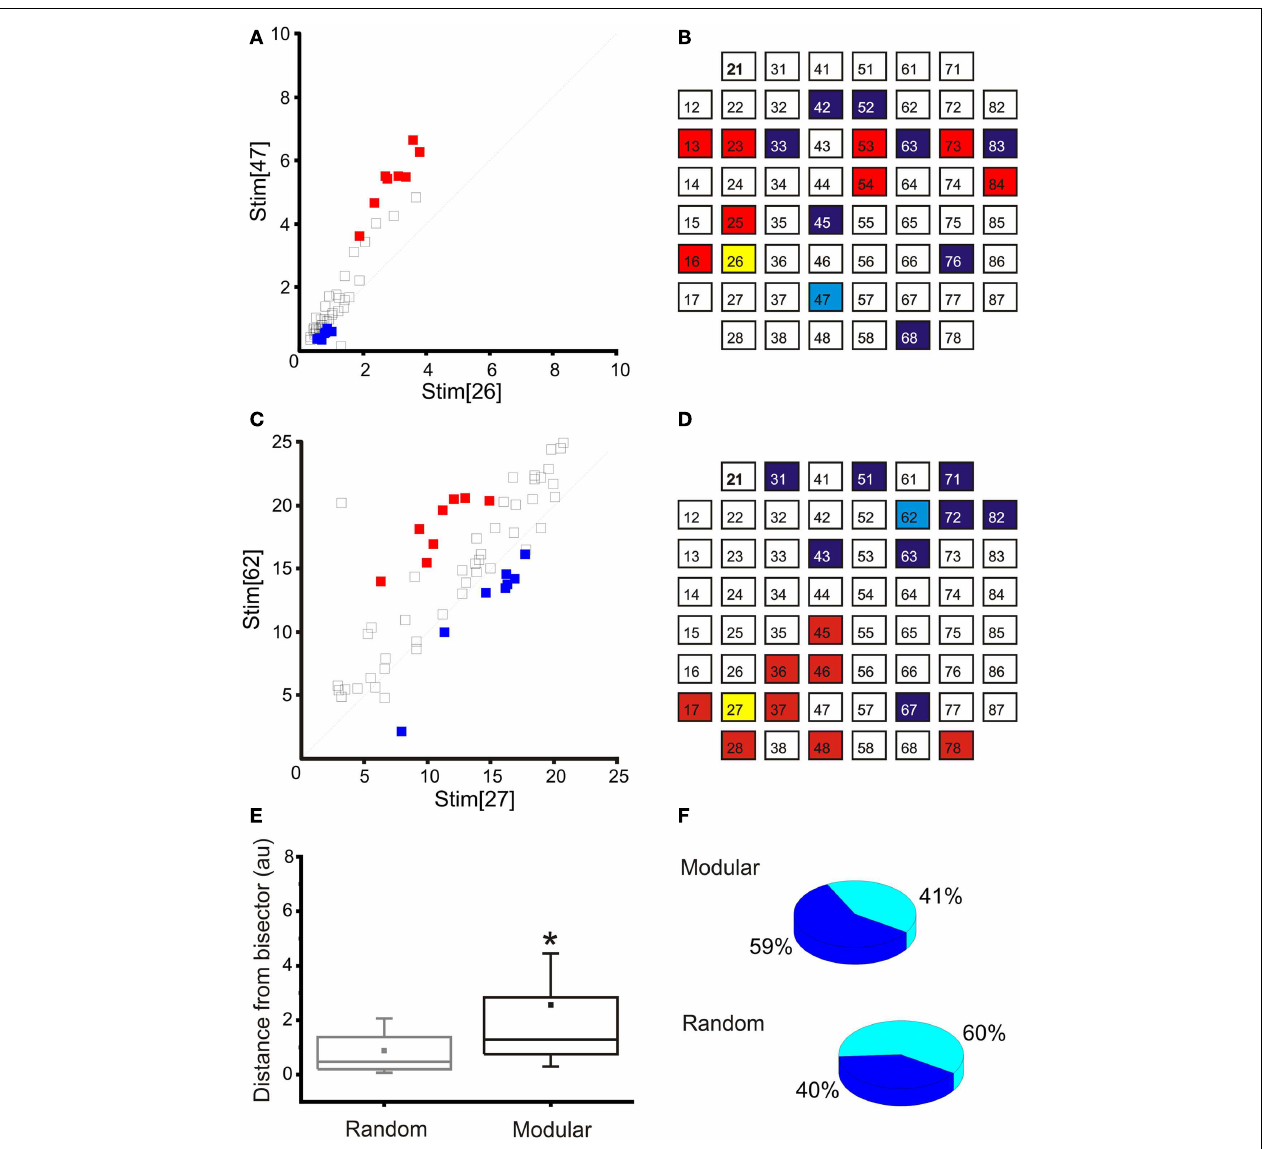
recording electrodes are close to the stimulating electrode and they follow the structure of the underlying network. (E) A box-plot representing the distances from bisector of the selected recording electrodes in the set of random and confined cultures used within this study ( N = 11 random and N = 6 modular cultures).The distribution of the distances in the modular case is significantly higher than in the random case. Box range: percentile 25–75; box whiskers: percentile 5–95; line: median; square: mean. Mann–Whitney test for not-normal data, significance level = * p < 0.05. (F) Pie chart representing the percentage of networks in which at least 50% of the recording electrodes were selected in the same compartment of the stimulating electrode.The percentage is higher for the modular networks ( N = 11 random and N = 6 modular